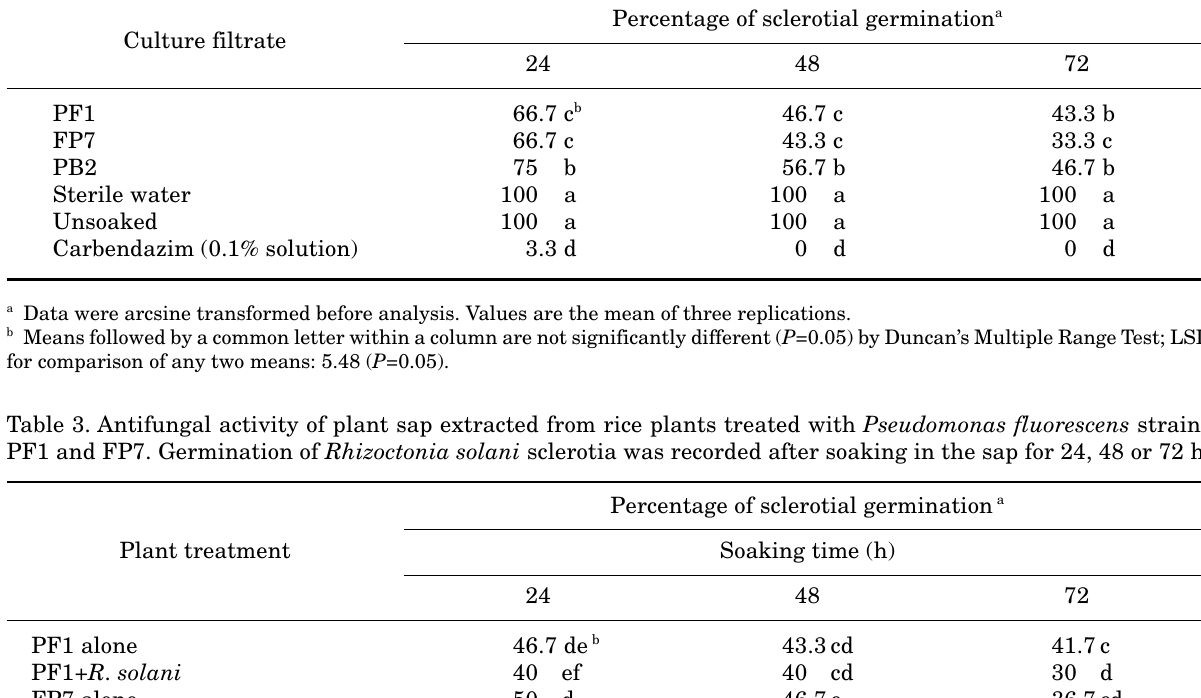
Table 2. Antifungal activity of bacterial culture filtrate against sclerotia of Rhizoctonia solani with different soaking times (24, 48, and 72 h).